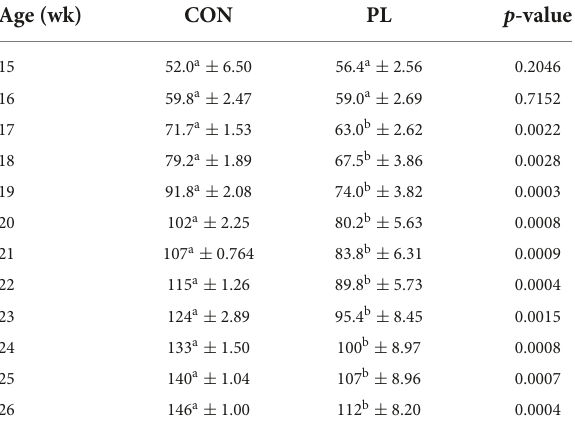
TABLE 4 Body weight (kg) of the animals in both groups (mean ±